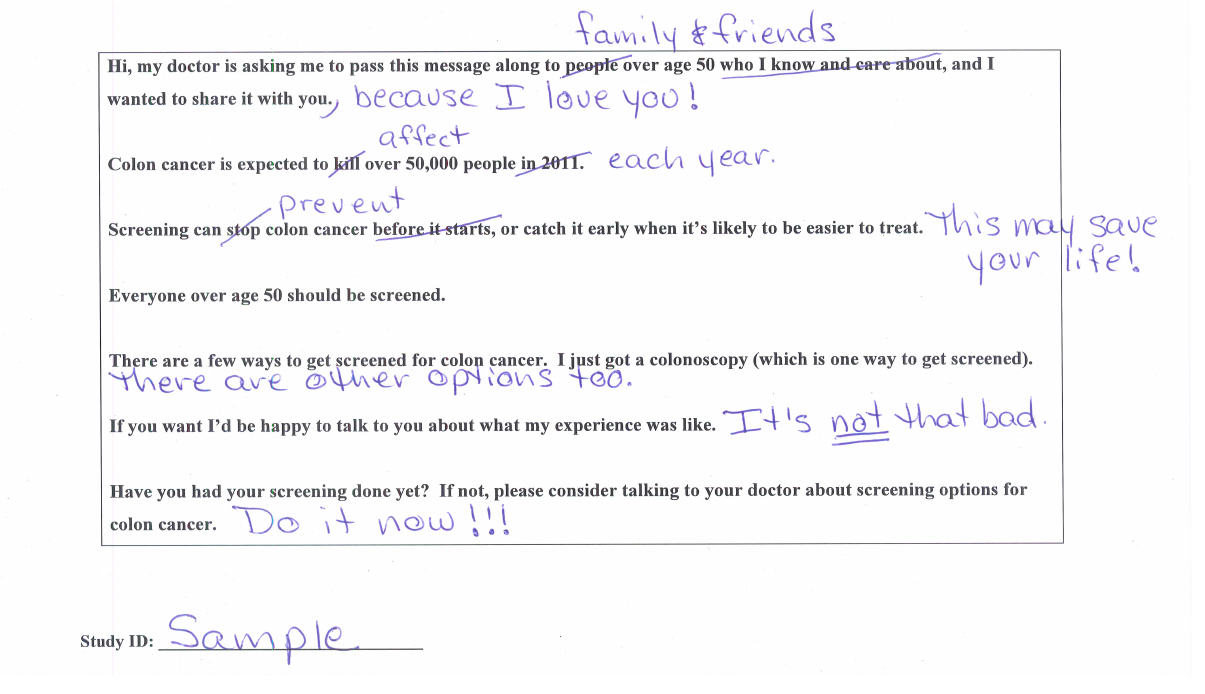
Figure 1. Colorectal cancer screening message template with edits